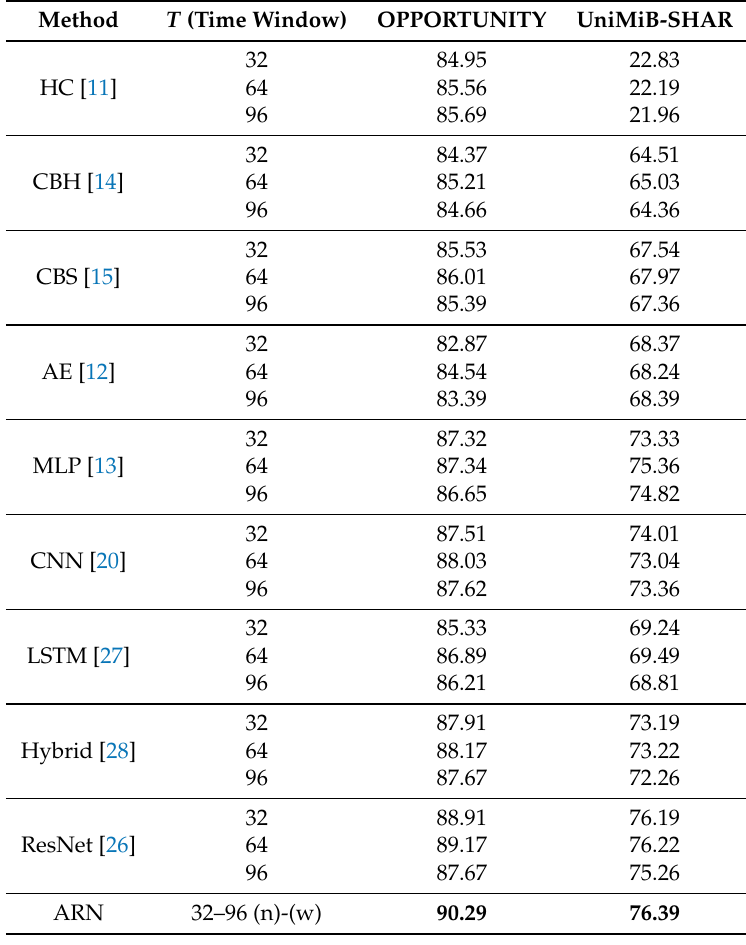
Table 7. Weighted F 1 -score performances of different methods on the OPPORTUNITY and UniMiB-SHAR datasets. (n) and (w) denote the narrow and wide paths, respectively. Method T (Time Window)